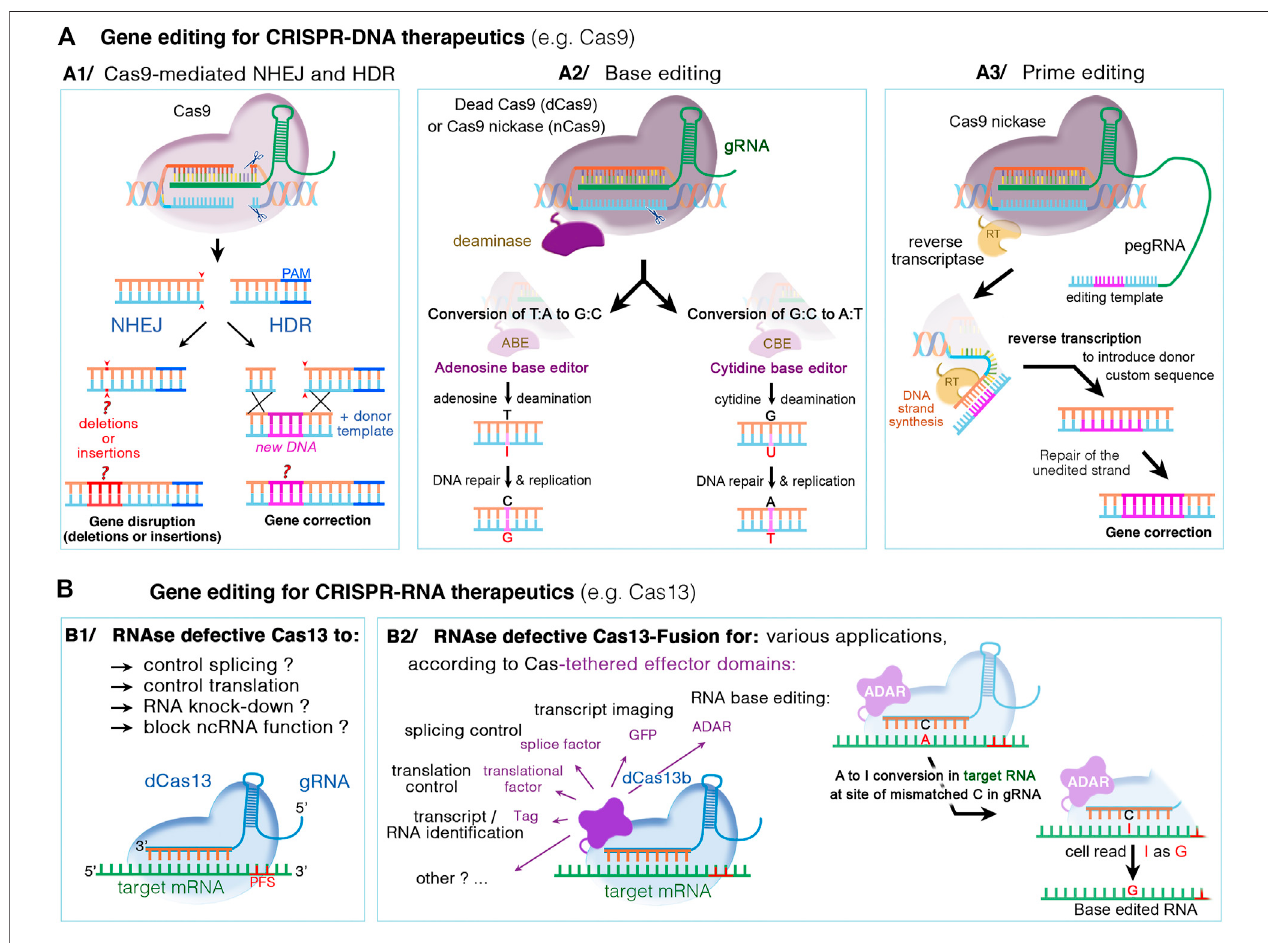
FIGURE 5 | DNA- and RNA-based genome editing to manipulate disease gene-of-interest. Different mechanisms occur, depending on the type of CRISPR/Cas nuclease and supplied editing tools. (A1) The DNA CRISPR/Cas nucleases such as Cas9 or Cas12 can bind and cleave the genomic DNA. The double-stranded DNA breaks can then undergo repair by either the nonhomologous end joining (NHEJ) or homology-directed repair (HDR). NHEJ is a random and highly error prone mechanism that incorporates insertion/deletion mutations, called indels, causing gene disruption (or silencing). In HDR, the DSB can be repaired by externally addinga donor DNA template that ishomologous tothe target sequence. The donor template is copied into thetargetedsite, resulting in adirected precise repair ofthe defective DNA sequence. (A2) Base editing relies on inactivated Cas nucleases (dcas) with preserved DNA targeting but without DNA cleavage, and could thus be used innon-dividingcells.ThedCasnuclease(forinstanceCas9nickase,nCas9)iscoupled toadeaminase,cytidine(CBE) oradenosine(ABE),whichmakeitpossibletoedit speci fi c nucleotide without DNA double break: C-to-T transitions by CBE editors or A-to-G transitions by ABE editors. (A3) Prime editing is suitable to edit both point mutations and larger deletions or insertions. Here, dCas9 is fused with an engineered reverse transcriptase enzyme (RT), combined with a prime editing guide RNA (pegRNA)thatservetobothpositiontheenzymeattargetsiteandprovidethetemplatesequencenecessarytocorrectorreplacethedefectiveDNAregion. (B)